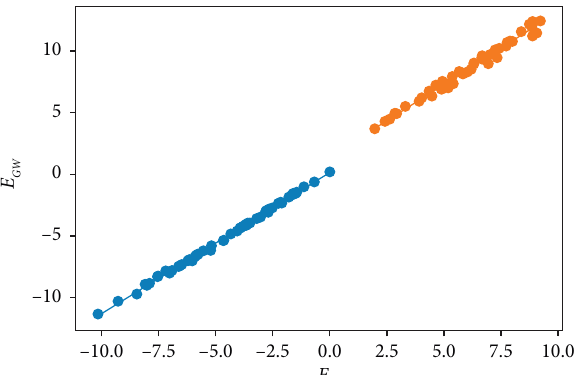
Figure 3: Scissor operator correction in QP and renormalization of conduction and valence bands. E